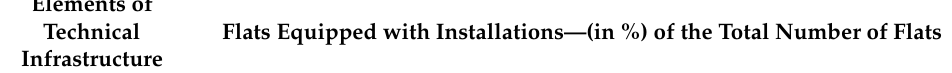
Table 2. Degree of equipment of rural communes with the basic elements of technical infrastructure from 2010 to 2018.